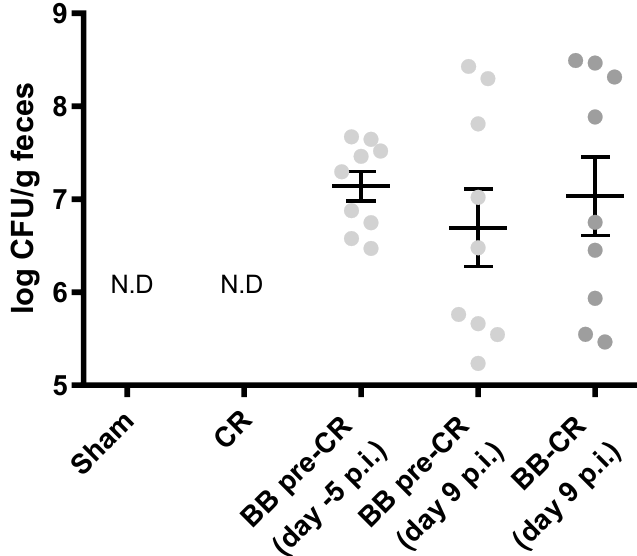
Figure 2. Fecal BB75 load before and after infection. Real-time PCR quantification of fecal BB75 in all groups of mice (n = 9/group) after C. rodentium (CR) infection, and in BB pre-CR group two days after initiation of BB75 (i.e., five days before infection). Statistical significance was determined by Student’s t-test, data presented as mean ± SE. N.D, not detectable.